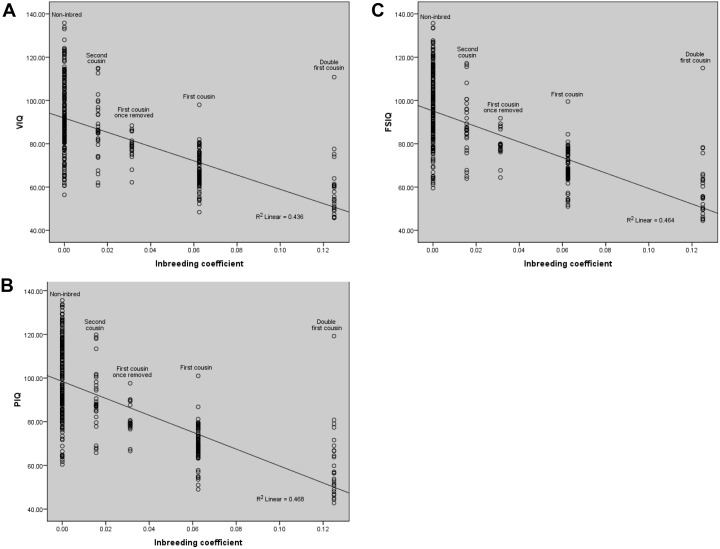
Inbreeding depression on cognitive abilities.The regression analysis presents almost similar trend for VIQ, PIQ and FSIQ. The slope depicts fitness decline (regression slope) with increase of inbreeding coefficient (F). The observed linear decline in fitness for cognitive parameters; (A) VIQ (R2 = 0.436), (B) PIQ (R2 = 0.468) and (C) FSIQ (R2 = 0.464) are found to be significant. Pearson correlation ‘r’ for VIQ, PIQ and FSIQ are −0.660, −0.684 and −0.681 respectively, and found to be statistically significant (p<0.01). The negative values indicate the decreasing trend for cognitive abilities due to inbreeding.